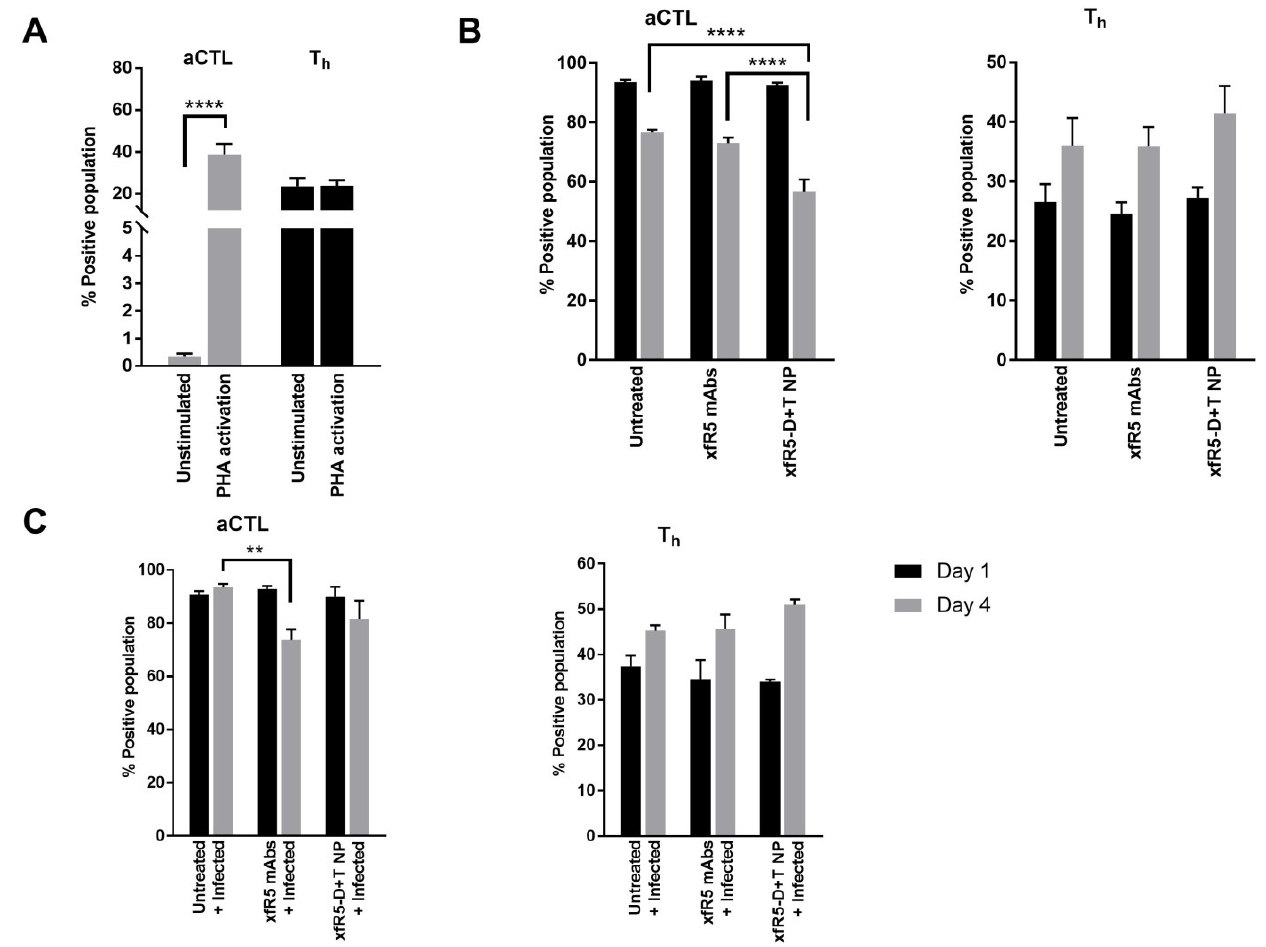
Figure 4. Effects on effector (E T-cell) phenotype upon treatment (with xfR5-D+T NP and xfR5 mAbs) compared to untreated conditions during PrEP and HIV-1 infection. ( A ) Comparative effect on aCTL (CD8+ E T-cell) and T h (CD4+ E T-cell) phenotype under unstimulated and stimulated (PHA-activated). ( B ) Under HIV challenge condition: aCTL (left graph) and T h (right graph) population on day 1 (black bar) and day 4 (gray bar). ( C ) The treatment effect in the presence of HIV-1 infection, on aCTL (left graph) and T h (right graph) on day 1, and day 4. Each data set represents the mean ±